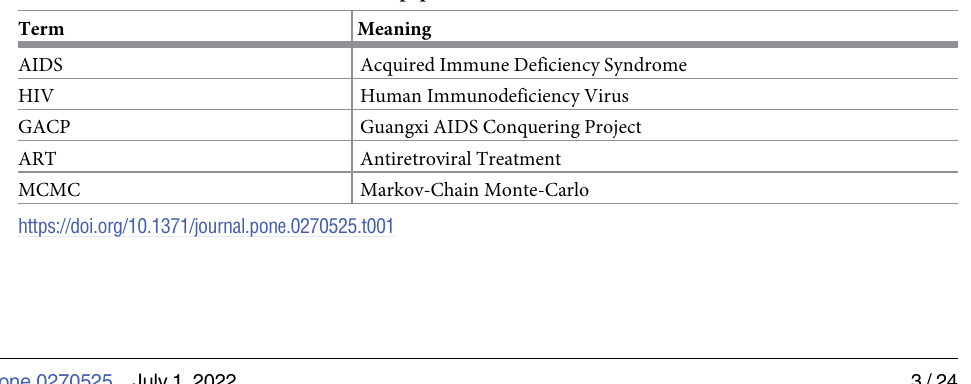
Table 1. A list of the abbreviations used in the